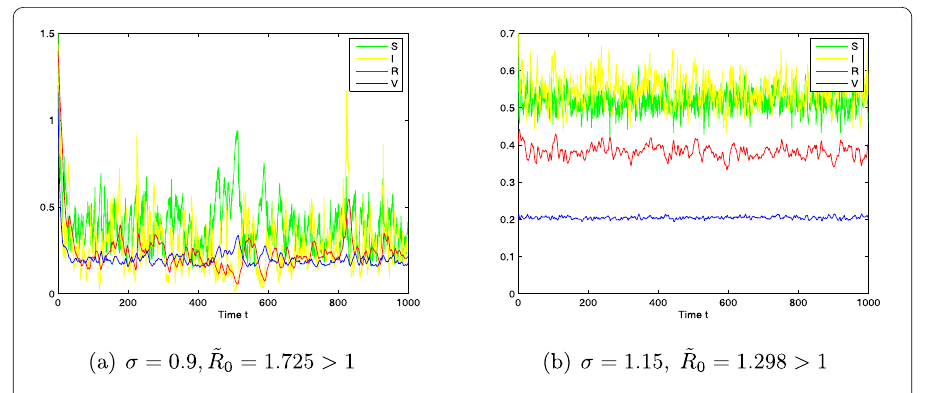
Figure 2 Simulation for paths S ( t ), I ( t ), R ( t ), and V ( t ) for the stochastic system with initial value ( S (0), I (0), R (0), V (0)) = (0.5,0.06,0.5,0.5) for different noise intensities σ = 1.15 ( a ) and σ = 0.9 ( b )